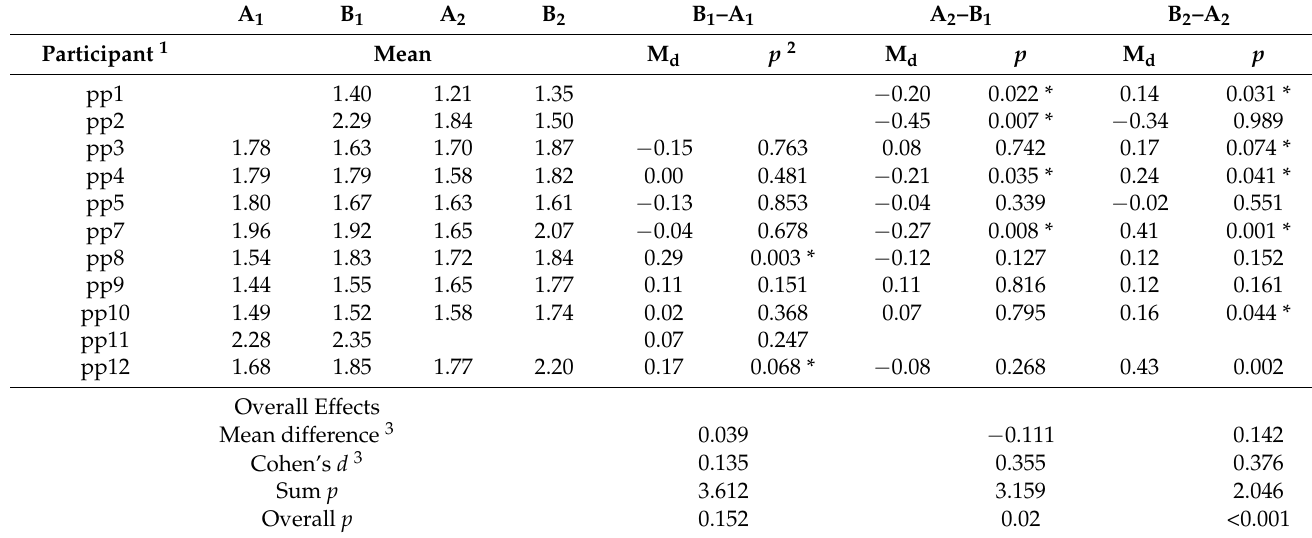
Table 4. Mean lx log10 values and mean differences and p -values for all